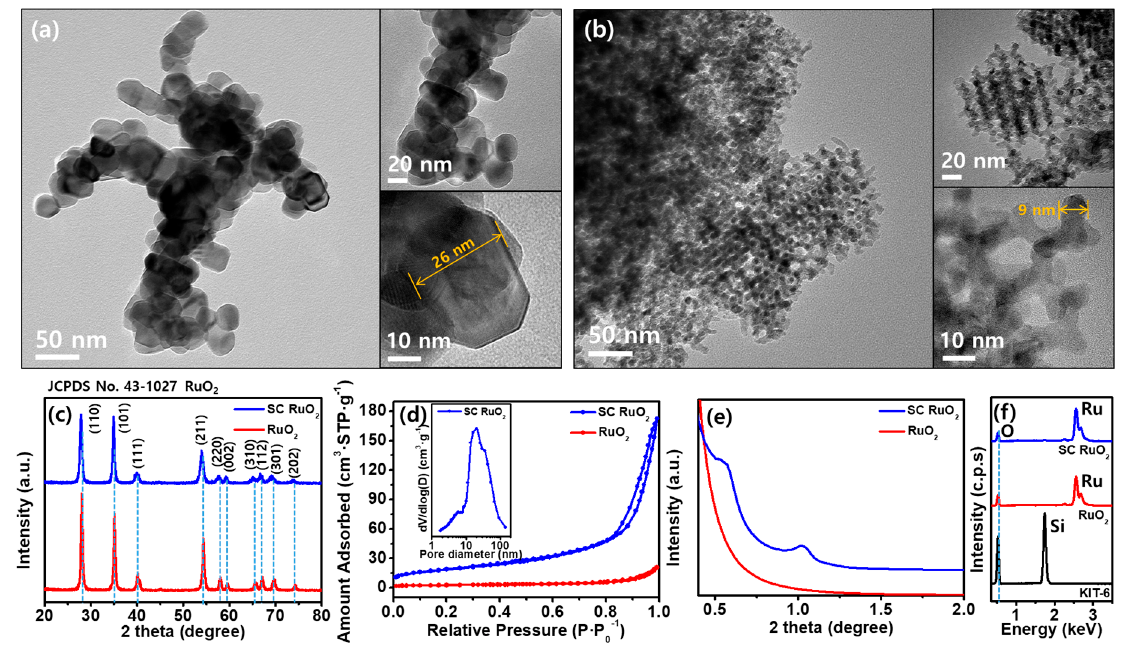
Figure 2. TEM and HRTEM image of ( a ) RuO 2 and ( b ) structure-controlled (SC) RuO 2 . ( c ) XRD patterns, ( d ) nitrogen adsorption–desorption isotherm (inset: pore size distribution of SC RuO 2 ), ( e ) SAXS patterns of RuO 2 and SC RuO 2 . ( f ) EDS spectra of KIT-6, RuO 2 and SC RuO 2 .